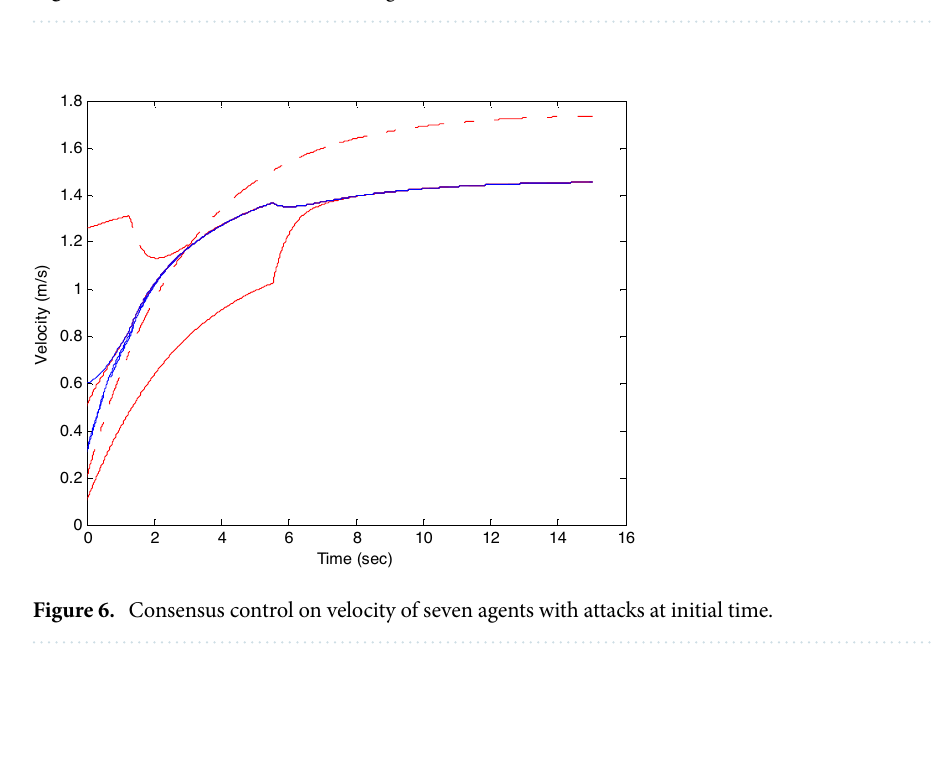
Figure 5. Consensus control of seven agents.